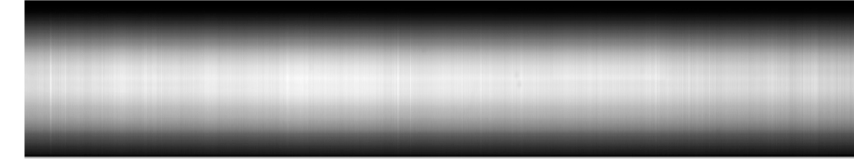
Figure 9. The correction result of calibration data after Step 1.